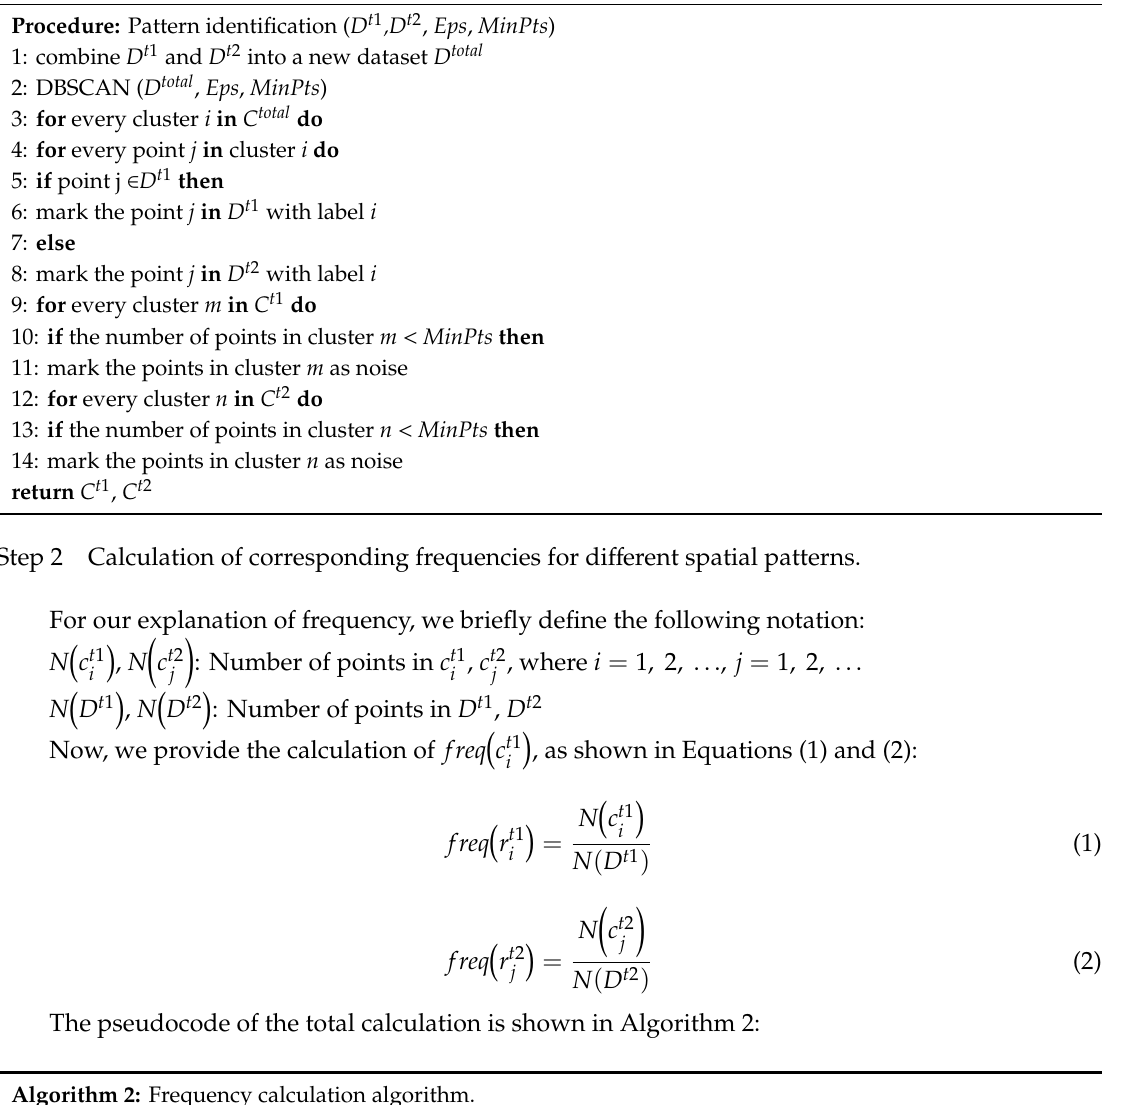
Algorithm 2: Frequency calculation